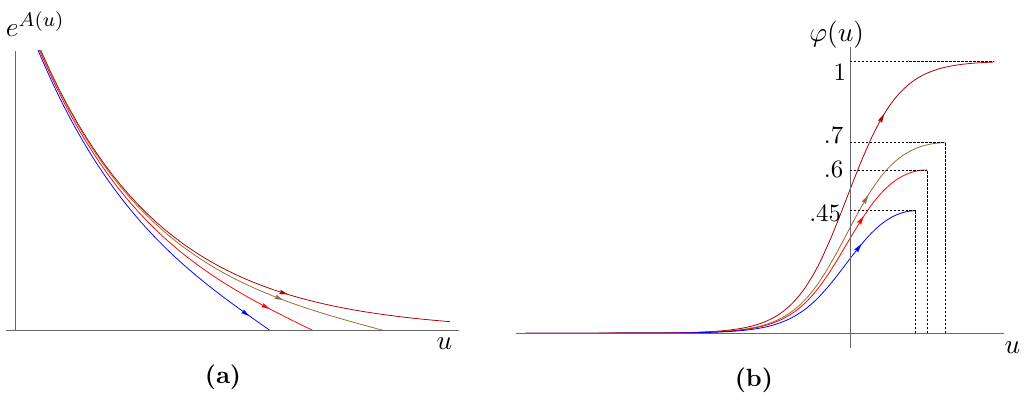
Figure 13. (a): scale factor e A as a function of u for the (cid:13)ows denoted by 1,2,3 in (cid:12)gure 11. For the (cid:13)at case, the scale factor is depicted as the dark red curve and only shrinks to zero at u ! 1 . For the positive curvature cases, the scale factor e A shrinks to zero at (cid:12)nite values of u . (b): scalar (cid:12)eld ’ ( u ) as a function of u . For the (cid:13)at case, the scalar (cid:12)eld arrives at the